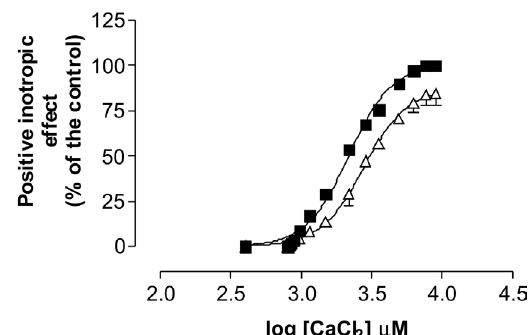
FIGURE 5 - Effect produced by AqF on the positive inotropic response obtained by increasing the extracellular calcium concentration in guinea pig isolated left atria. Curves show data before (■) and after (∆) adding 100 m g/mL of AqF to the organ bath (Resting tension: 4.9 mN; temperature: 29 ± 0.1 ºC; stimulli: 1.5 Hz; 400 V; 0.5 msec; n = 3 atria; Fcalc = 220.8; F(0.01; 29; 60) = 2.19; * p <